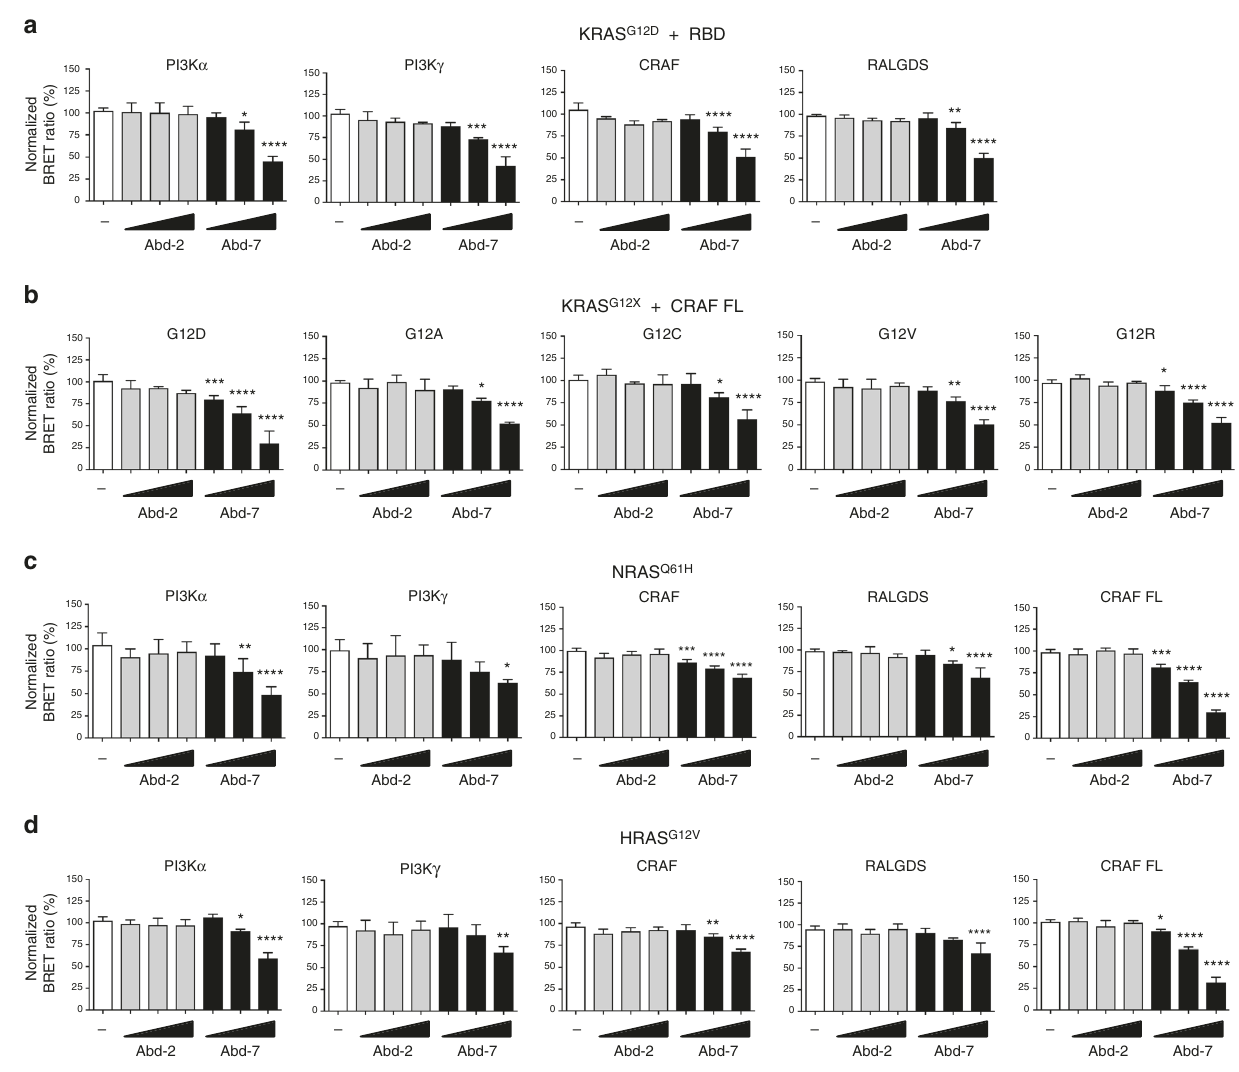
Fig. 4 Abd-7 disrupting RAS-effector interactions. HEK293T cells were transfected with different BRET-based RAS biosensor expression vectors to evaluate the inhibition of RAS PPI in cells by compound Abd-7. Transfection vector encoded full-length RAS was fused to the donor molecule RLuc8 and the effectors fused to the acceptor molecule GFP 2 . a Effect of Abd-2 and Abd-7 on KRAS G12D interaction with PI3K α , PI3K γ , CRAF or RALGDS. The BRET signal is plotted as a % of control cells treated with DMSO only and dose response to 5, 10 and 20 μ M of each compound. b Effect of Abd-2 and Abd-7 on the BRET signal from interaction of KRAS G12 mutants (Rluc8-KRAS G12 ) and full-length CRAF (GFP 2 -CRAF FL). c , d Effect of Abd-2 and Abd-7 on the interaction of NRAS Q61H ( c ) and HRAS G12V ( d ) with various RAS effectors domain and with full-length CRAF. The BRET ratio corresponds to the light emitted by the GFP 2 acceptor constructs (515 nm ± 30) upon addition of Coelenterazine 400a divided by the light emitted by the RLuc8 donor constructs (410 nm ± 80). The normalized BRET ratio is the BRET ratio normalized to the DMSO negative and calculated as follows: (BRET compound /BRET DMSO ) x 100, where BRET compound corresponds to the BRET ratio for the compound-treated cells, BRET DMSO to the DMSO-treated cells. Each experiment was repeated at least three times. Statistical analyses were performed using a one-way ANOVA followed by Dunnett ’ s post-tests (* P < 0.05, ** P < 0.01, *** P < 0.001, **** P < 0.0001). Where error bars are presented, they correspond to mean values ± SD of biological repeats ( a – c